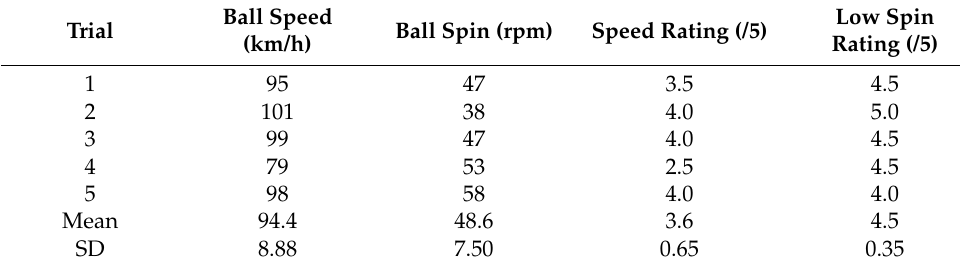
Table 2. Dynamics of knuckle ball trajectory of soccer ball